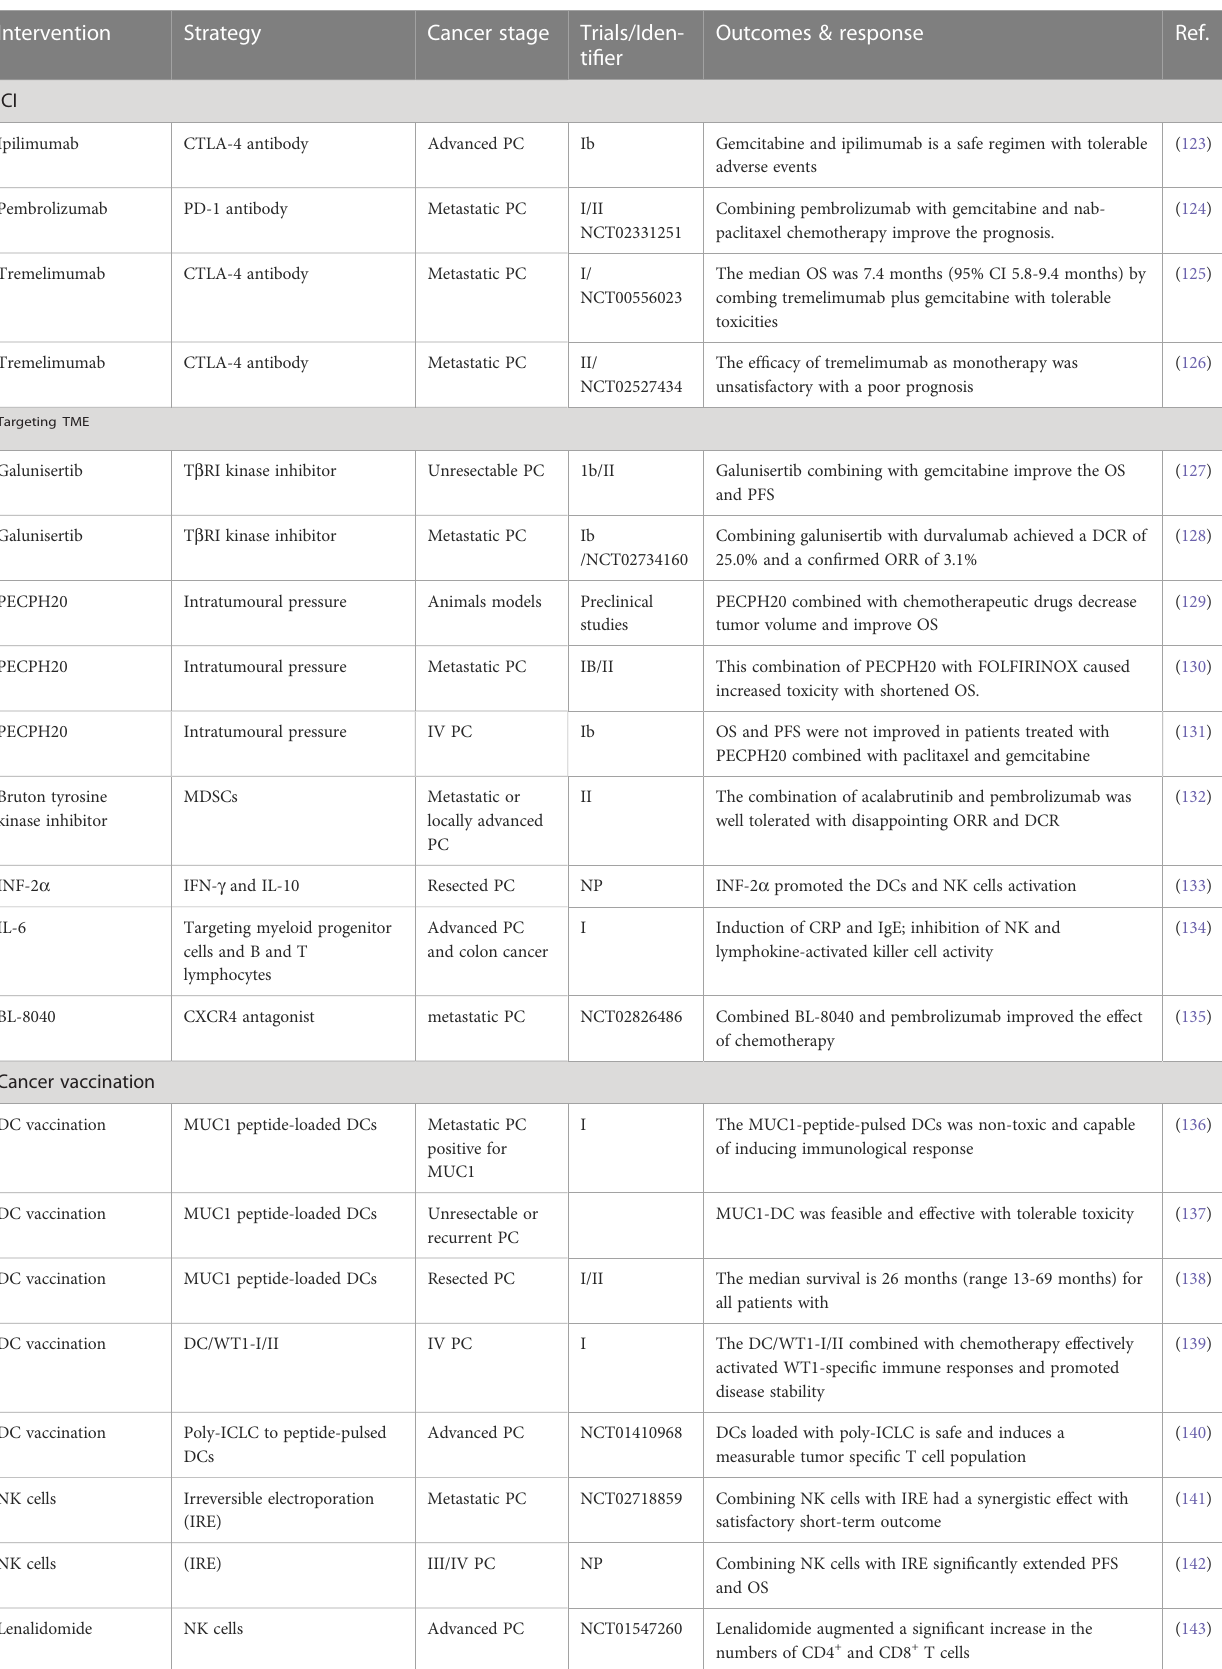
TABLE 2 Immunotherapy strategy for pancreatic cancer based on tumor